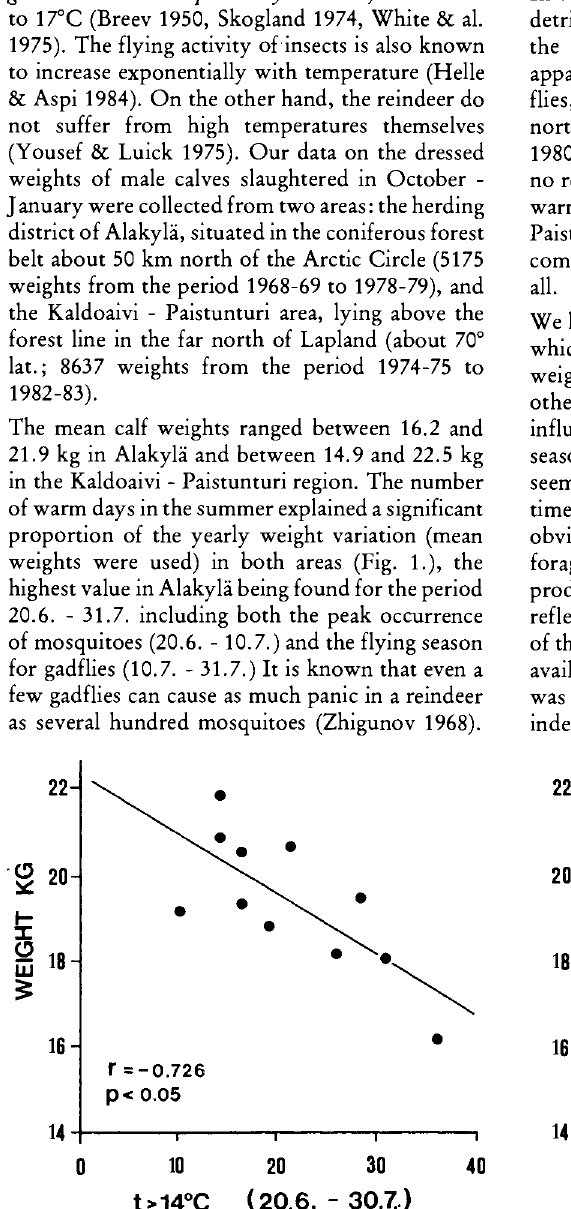
1. The relationships between the number of warm days during the insect season and the mean dressed weights of reindeer calves in autumn - early winter in Alakyla (left) and Kaldoaivi - Paistunturi (right). Each plot is the mean value of 85 - 1712 weight records.